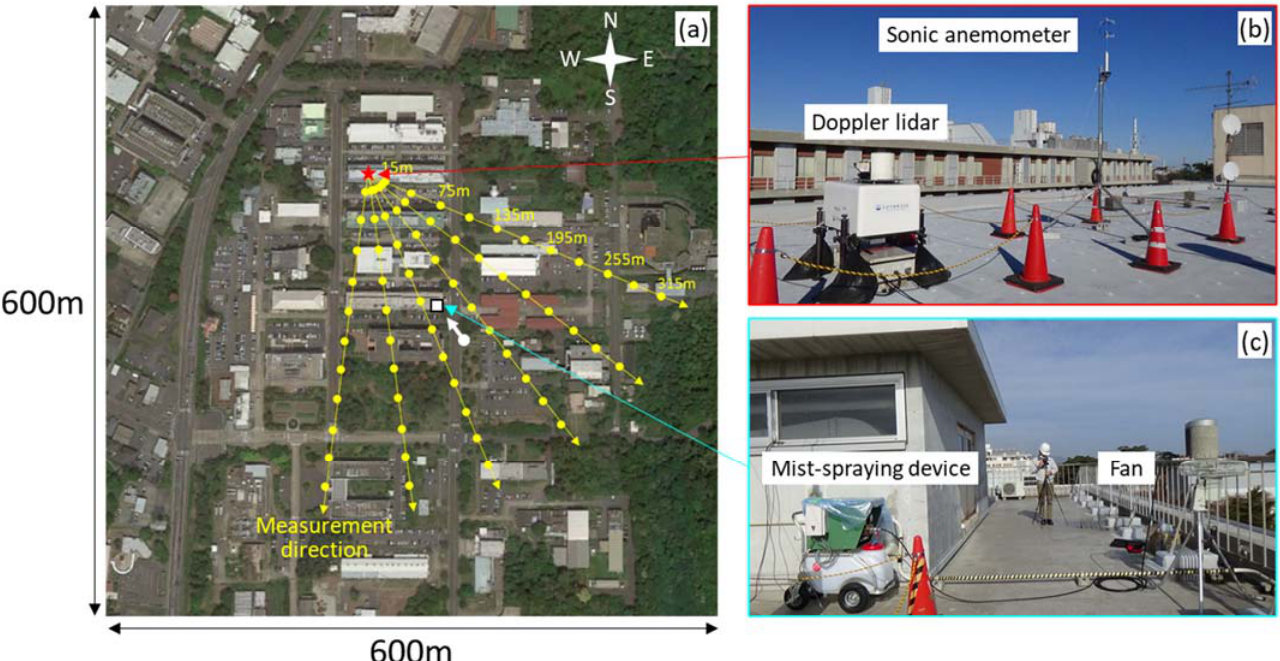
Figure 1. Locations of the meteorological observations and the mist-spraying system. ( a ) Study site in JAEA. ( b ) Doppler LiDAR and sonic anemometer. ( c ) Mist-spraying system. The photograph ( a ) is reproduced by Google TM earth graphic. The red star depicts a position of the Doppler LiDAR and sonic anemometer placed at the building rooftop. The yellow circles are measurement points of wind velocity by the Doppler LiDAR at elevation angle of 1.0°. The white square depicts a position of the mist-spraying system placed at the building rooftop. The white arrow indicates a position of the digital camera on the ground directed toward the mist-spraying system.